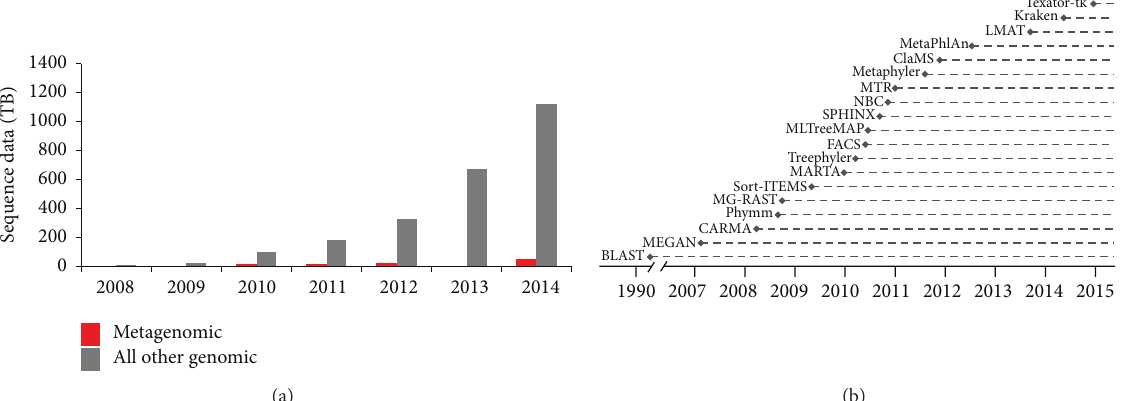
Figure 1: The rise of NGS data and taxonomic classification tools. (a) Data in terabytes (TB) based on NCBI SRA deposited data (data taken in January 2015). (b) A survey of metagenomic classification tools with peer reviewed publications until February